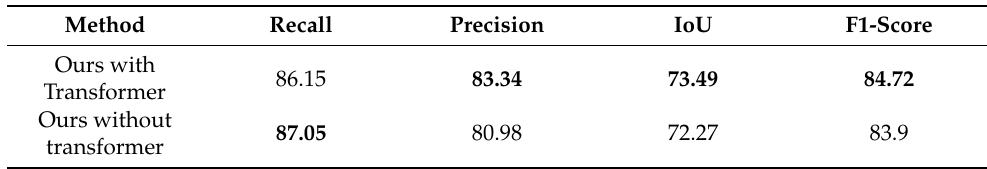
Table 5. Quantitative comparison results (%) between our method with and without the transformer module tested on the Massachusetts Building